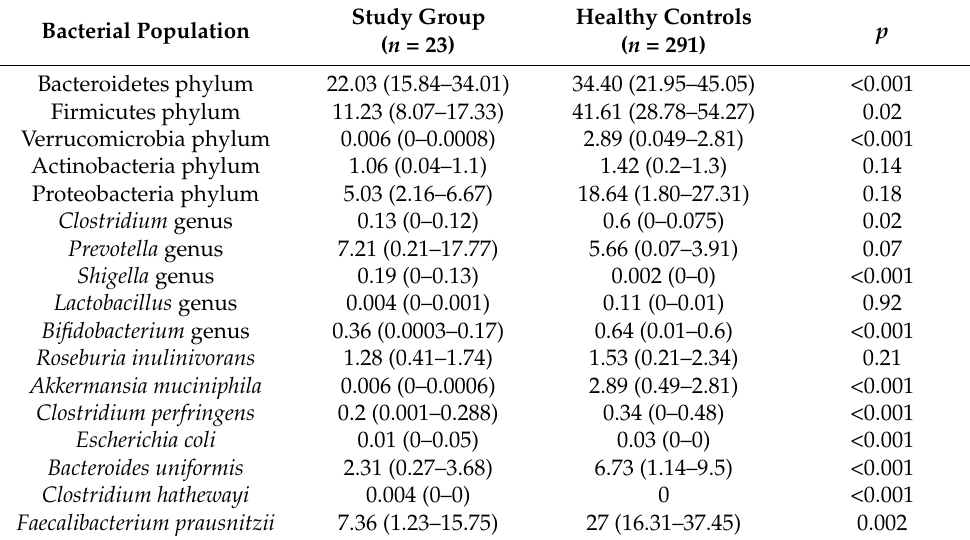
Table 2. Relative abundance of specific bacterial groups in stools of BC survivors and control 290 group by specific primers. The results are expressed as median % (25 – 75th). p value ≤ 0.05, 291 significant difference between the two groups, Mann-Whitney U test.